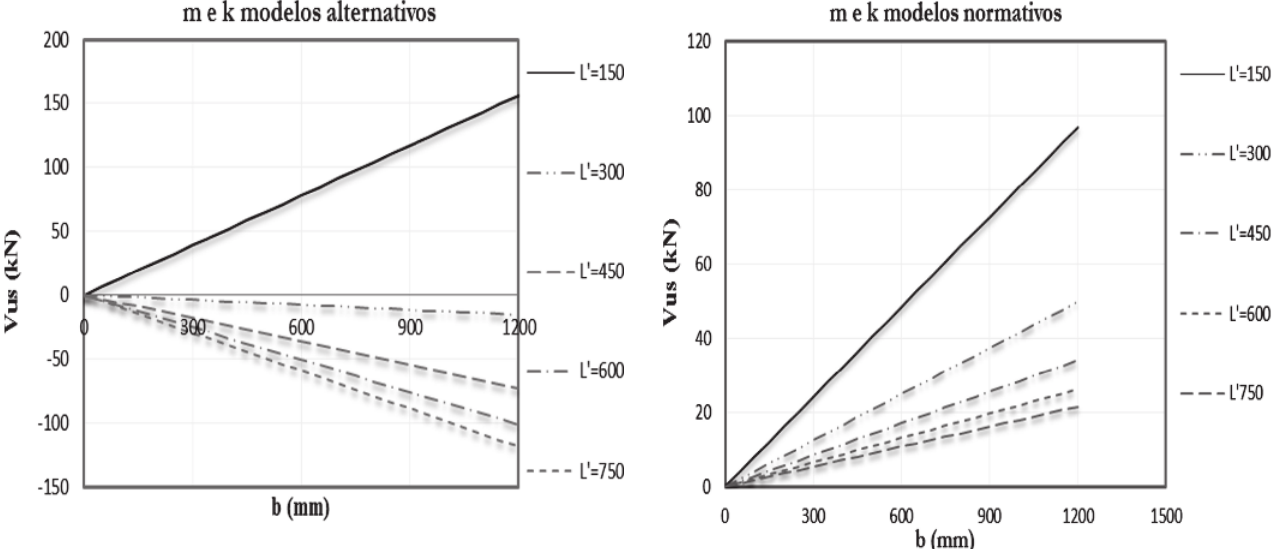
Resistência ao cisalhamento longitudinal ao adotar m e k dos modelos alternativo e normativo variando a largura das